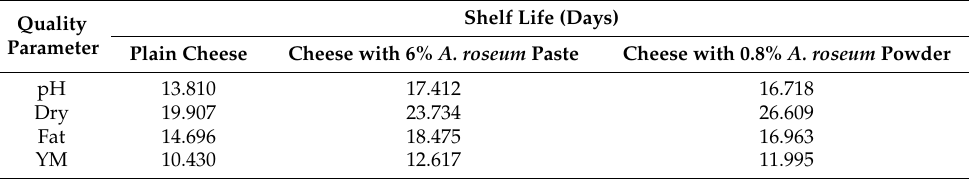
Table 6. Calculated shelf life values of plain and supplemented cheeses according to physicochemical and microbial quality